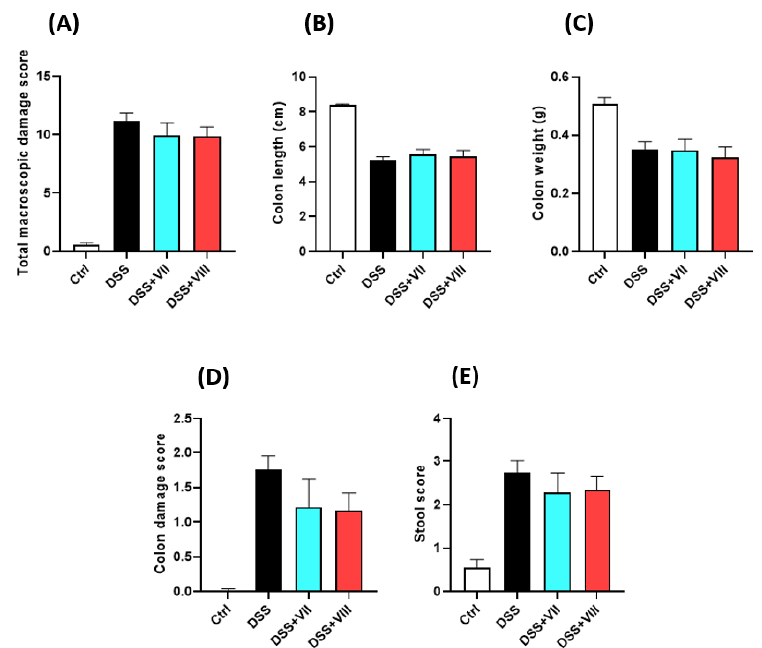
Figure 3. The effect of the peptides on colonic inflammation in DSS-induced mouse model of colitis: total macroscopic damage score ( A ), colon length ( B ), colon weight ( C ), colon damage score ( D ), and stool score ( E ) for control, DSS-only treated mice, and mice with DSS-induced colitis treated with 1 mg/kg peptide VII or peptide VIII twice daily. Data represent mean ± SEM of n = 5 – 10 animals per group.